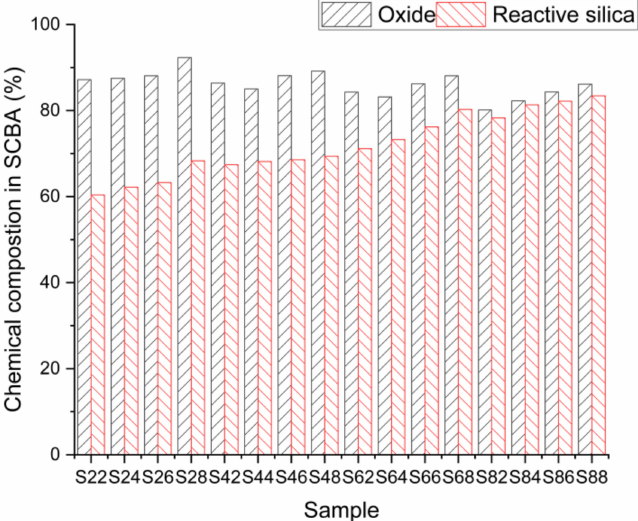
Figure 6. Reactive silica of di ff erent